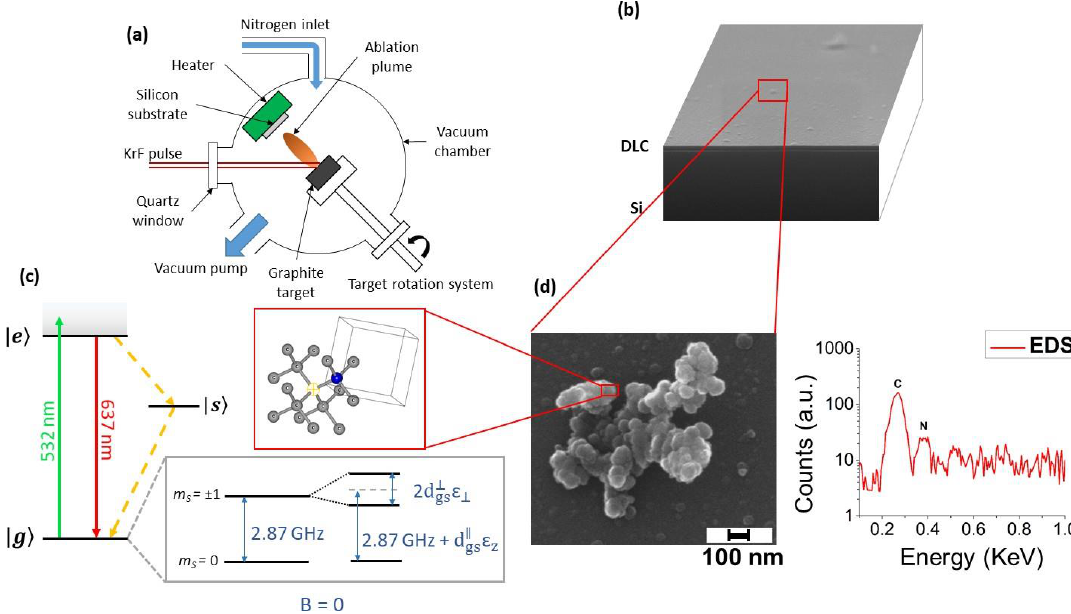
Figure 7. ( a ) Experimental setup of pulsed laser ablation (PLA). ( b ) SEM image of the synthesized sample: on the Si substrate a thin diamond-like carbon (DLC) film is deposited over which NDs are dispersed. ( c ) NV − center energy levels. When the NV is excited by using a green laser (green arrow), it can relax either radiatively (red arrow) or non-radiatively (yellow dotted arrow). The effect of the lattice strain, both in its parallel and perpendicular components with respect to the NV axis, on the degenerated m s = 1 spin states is represented (see text for details). In the red box: scheme of diamond crystal structure with an NV center, consisting of a nitrogen atom (blue sphere) and a nearest-neighbor carbon-vacancy (yellow circle) along the (111) direction. ( d ) Left-hand side: SEM image of one microparticle deposited on the DLC film, consisting of clustered C-nanoparticles with sizes below 50 nm. Right-hand side: corresponding EDXS spectrum. The carbon and nitrogen peaks are detected at, respectively, 0.27 and 0.38 KeV, indicating that the nitrogen is contained inside the nanoparticles’ cluster. In addition, the silicon peak from the Si substrate was detected at 1.74 KeV (not shown). Reproduced with permission from [64], Royal Society of Chemistry, 2018.